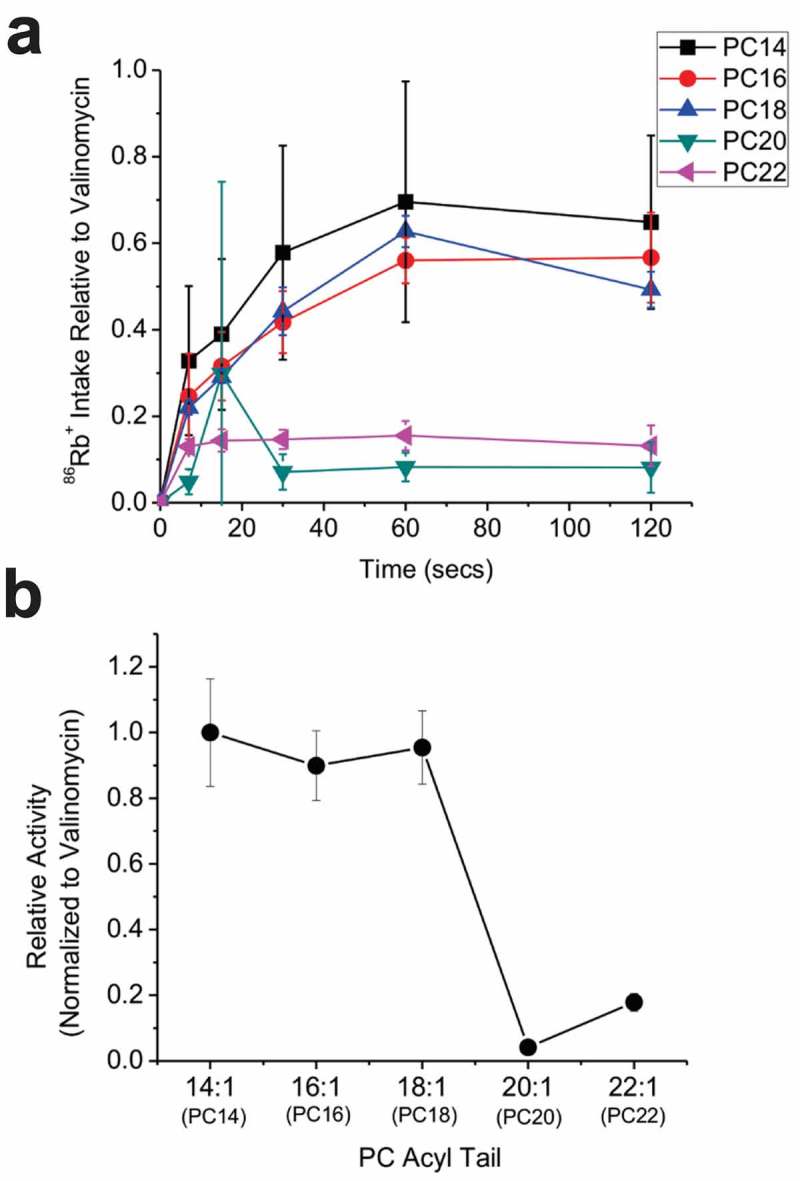
KcsA activity depends on membrane thickness. (a) Time courses of 86Rb+ influx into proteoliposomes containing 70 mol% of PC lipids varying in acyl tail length and 30 mol% POPG reconstituted with E71A KcsA channels (n = 6). Uptake was normalized to valinomycin, which quantifies the maximal uptake possible. (b) Valinomycin normalized counts at 120 swere plotted relative to counts in diC14:1PC/POPG, where maximal activity was observed.